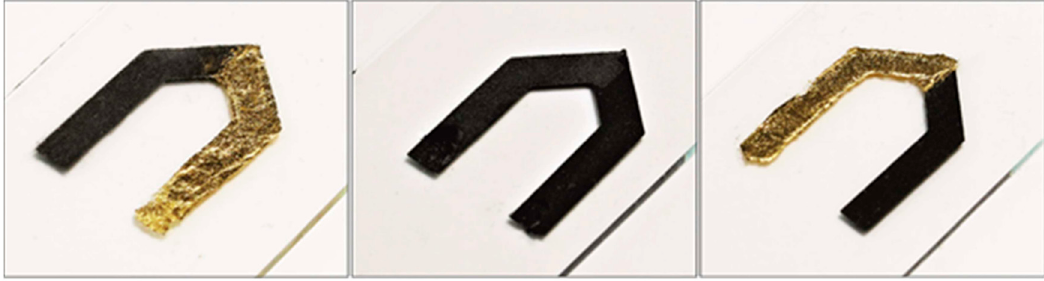
Figure 1. Left picture: 109-Au thermocouple, Middle picture: 109-2842 thermocouple, Right picture: Au-2842